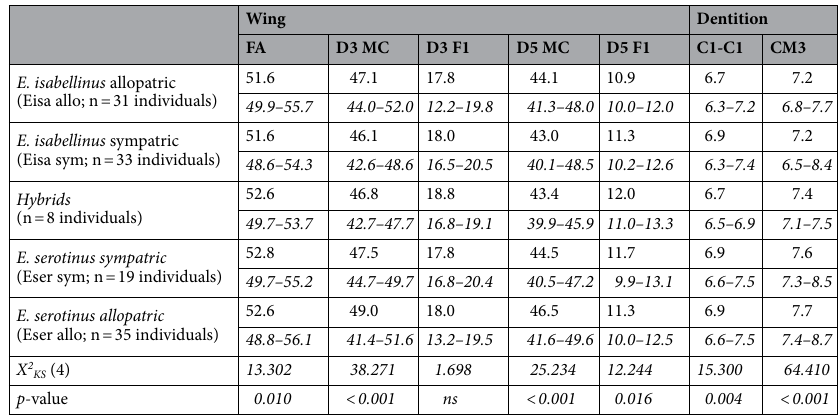
Table 1. Descriptive statistics of the morphometric traits of Eptesicus serotinus , E. isabellinus and their hybrids. Medians are shown above the range.